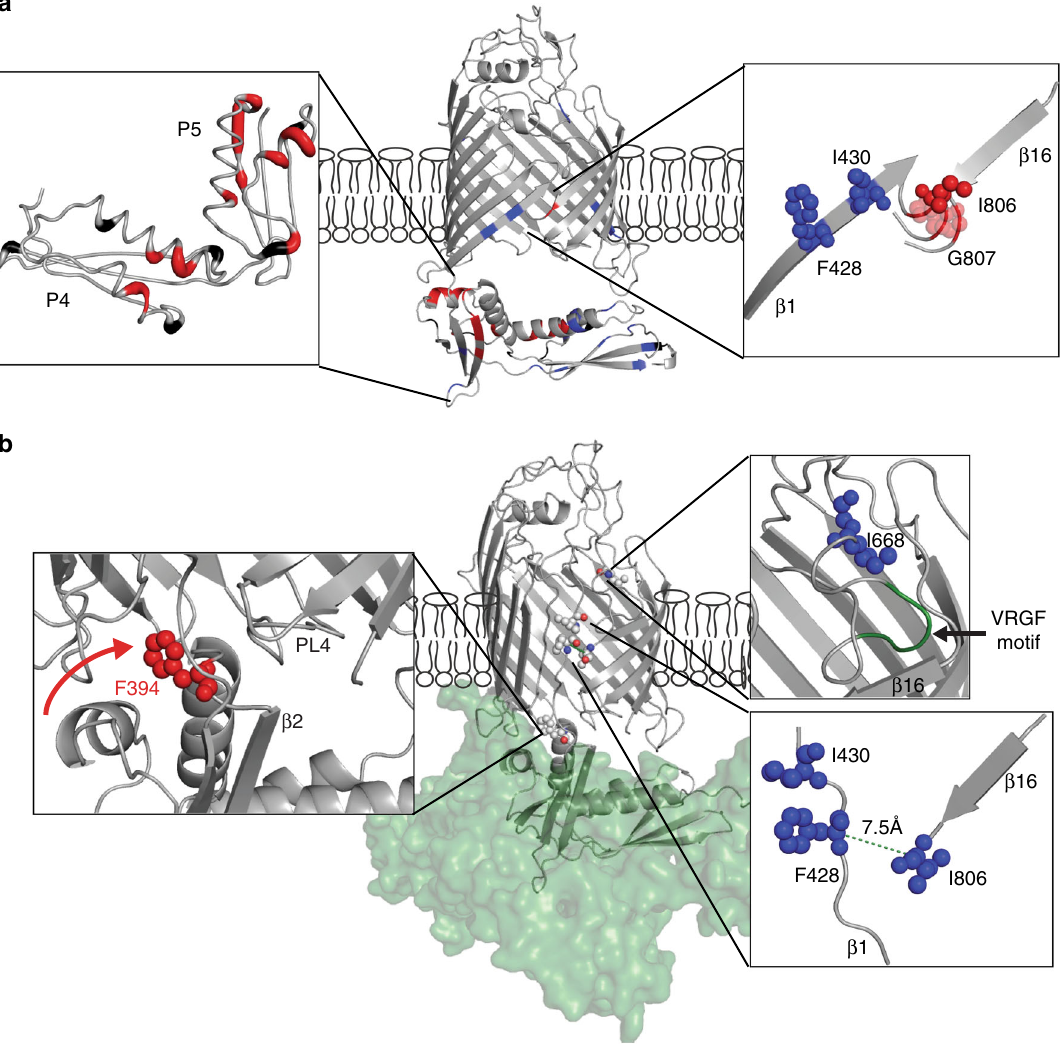
Fig. 5 Structure and dynamics of BamAP4P5 are in fl uenced by complex formation. a Dynamic BamAP4P5 protein region (indicated in red) as judged from ssNMR ( 1 H-detected and DNP) experiments in proteoliposomes. In blue are residues which show no signi fi cant changes upon complex formation. In black are residues that could not be assigned by ssNMR C α NH and CONH experiments. b Conformational changes within BamAP4P5 upon complex formation with the sub-complex BamCDE. Inset at left is the movement of P5 to beneath the β -barrel, indicated by the red arrow, a movement that is anchored in place by residues from periplasmic loop 4 and residue F394 (red), which exhibits chemical shift perturbation in ssNMR experiments. Inset at right top, the EL6 loop anchored to the barrel via the conserved VRGF motif, which exhibits no changes as judged by the proximal I668. Inset right bottom: distance measurement between I806 and F428 that allows to follow lateral gate opening occurring upon complex